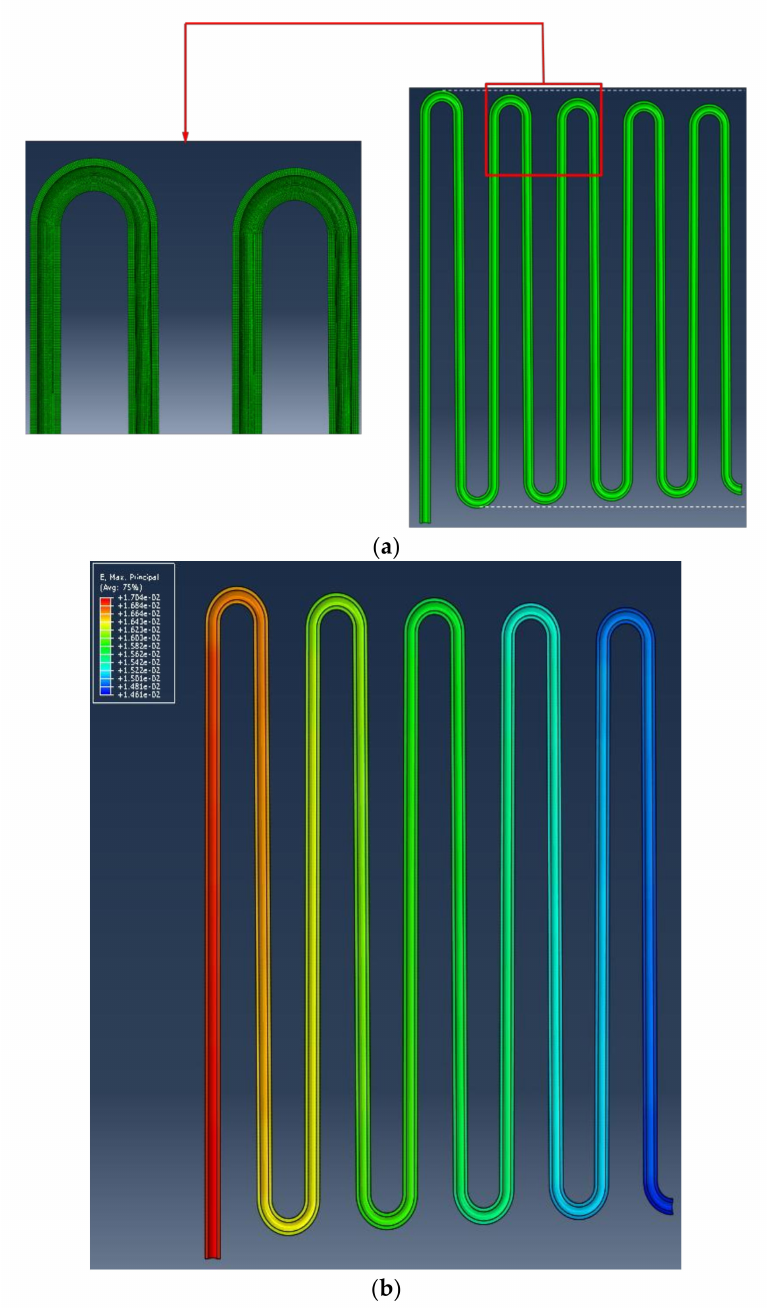
Figure 9. Tube displacements on the tube: ( a ) tube displacement shape, ( b ) the maximum principal strain